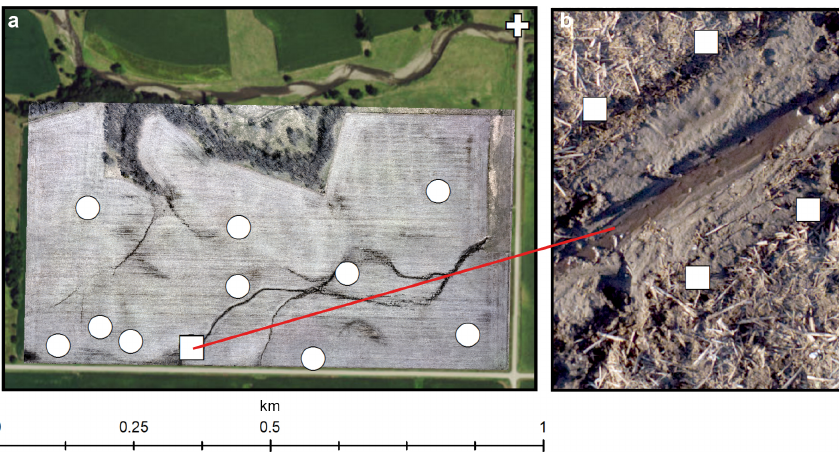
Figure 2. (a) Study site with field ground control points (GCPs; circles) and a state monument (cross) on the bridge in the upper right corner. (b) Selected AOI with channel GCPs (squares) for detailed surveys and comprehensive evaluation.